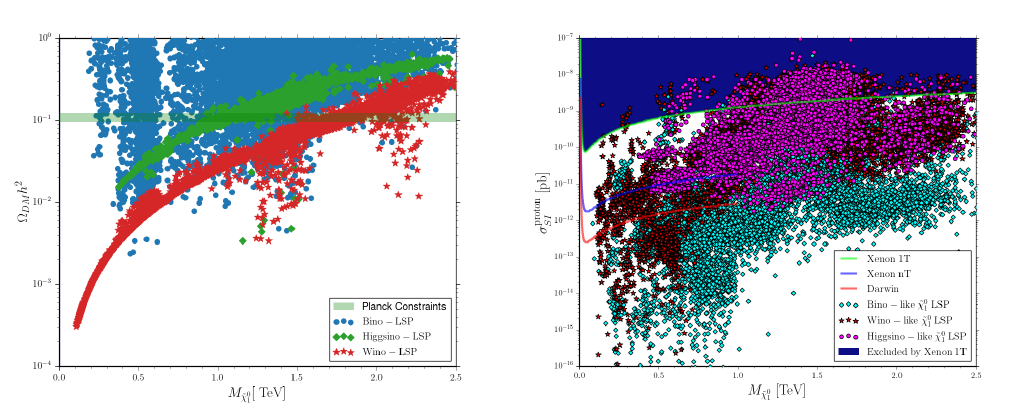
Figure 6 . Neutralino dark matter. Left panel: relic density plot for bino, higgsino or wino domi- nated neutralino LSP, compared to the measured values by Planck [137]. Right panel: direct detec- tion limits for neutralino LSP, depending on its composition, compared to the Xenon1T [138, 139] and Darwin [140]